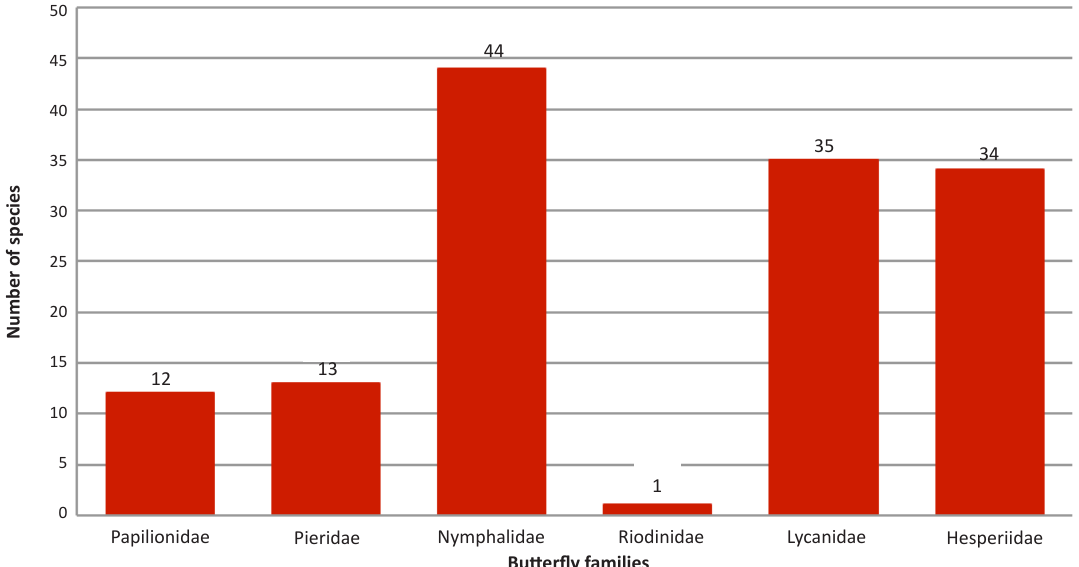
Figure 2. Family wise distribution of butterfly species in Kerala Agricultural University campus